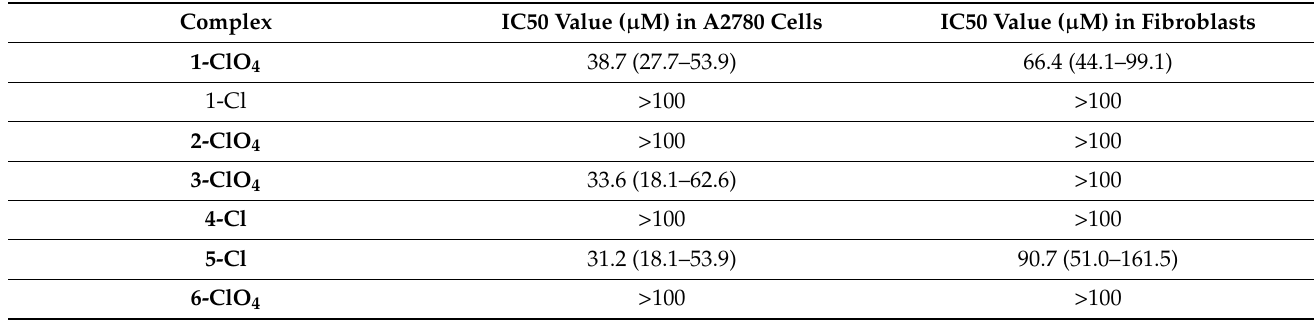
Figure 8. Results of the 3-(4,5-dimethylthiazol-2-yl)-2,5-diphenyltetrazolium bromide (MTT) assay in A2780 cells ( a ) and fibroblasts ( b ). Corresponding bar diagrams can be found in the Supplementary (Figure S16). Table 3. The IC50 values (95% confidence interval) in A2780 and fibroblasts